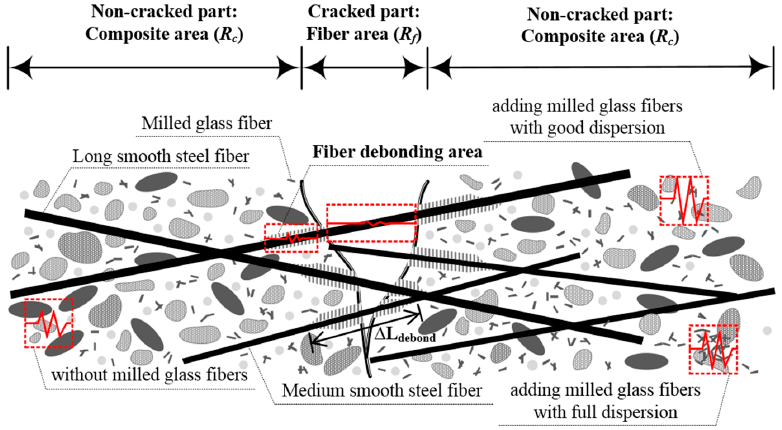
Figure 2. Schematic of HPFRCCs under tension.